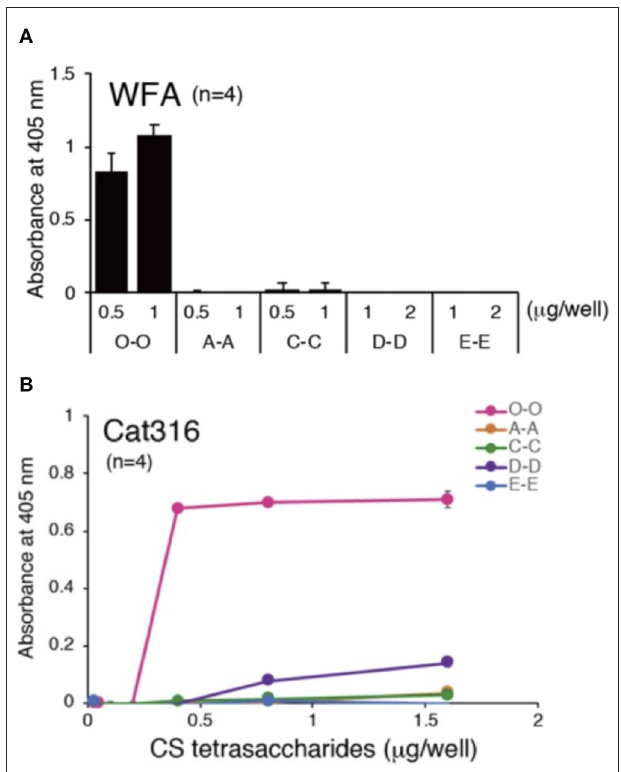
FIGURE 4 | PNN CS-GAG recognizing lectins and antibodies bind to the non-sulfated CS-O (0S) isomer. Both (A) WFA and (B) Cat-316 PNN glycan-recognizing antibodies specifically interact with non-sulfated CS-O (0S) tetrasaccharides (see Nadanaka et al., 2020). Chemically synthesized biotinylated tetrasaccharides (O-O, A-A, C-C, D-D, and E-E) were immobilized onto streptavidin-coated plates and binding affinity of WFA and Cat-316 to the different CS tetrasaccharides were measured by ELISA. CS, chondroitin sulfate; WFA, Wisteria floribunda agglutinin.